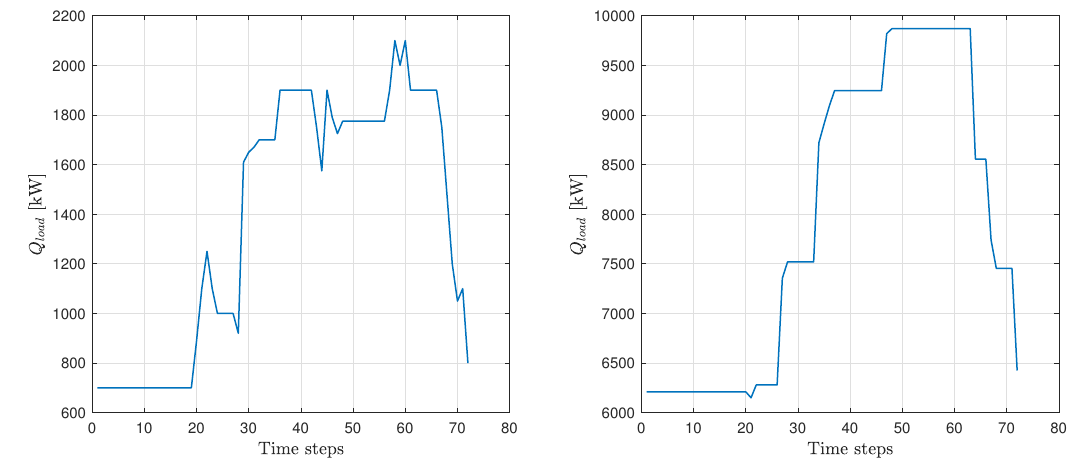
Figure 3. Cooling load demand profile for case study 1 ( left ) and case study 2 ( right